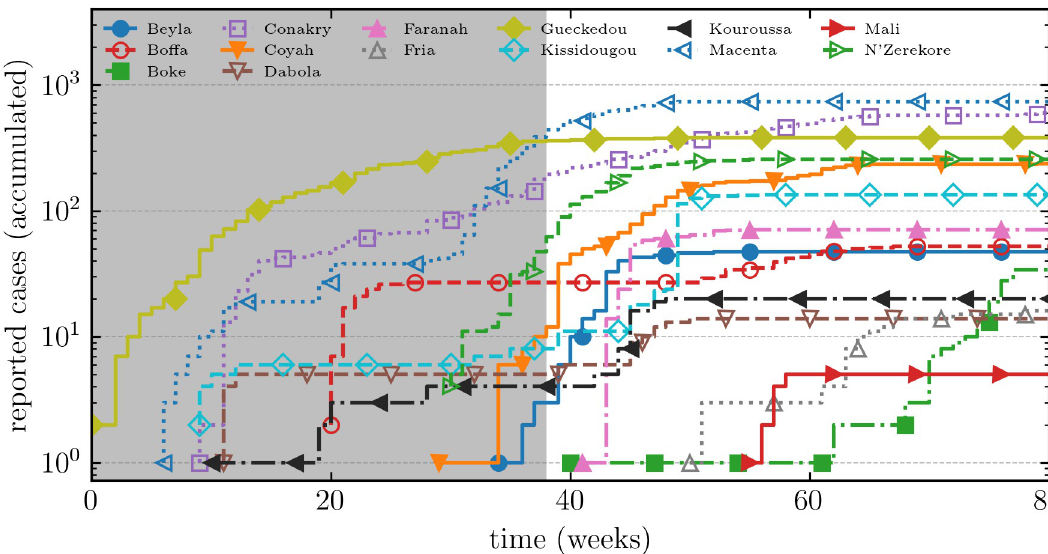
Fig 1. Ebola virus epidemic in Guinea. Shows the cumulative number of confirmed or probable cases at the district level. The time series begins on January 5, 2014, ends on May 8, 2016, and advances weekly increments. On August 8, 2014, several months after its beginning, the World Health Organization declared the outbreak in West Africa a Public Health Emergency of International Concern. On September 18, 2014, the United Nations established The United Nations Mission for Ebola Emergency Response (UNMEER). The grey shaded regions show the time before the creation of UNMEEER. Guinea was declared free of Ebola by the World Health Organization on June 1. We also show epidemic curves for 14 of 33 Guinean prefectures. The outbreak originated in the Gue´cke´dou prefecture and quickly spread to Conakry, the capital city. Data from the World Health